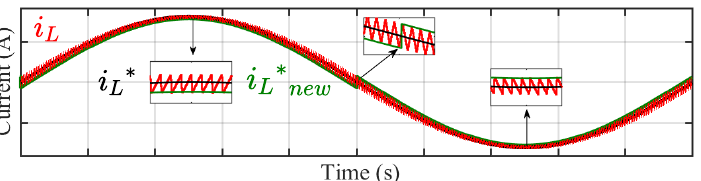
Figure 12. Sketch of Inductor current obtained with the variable offset corrected reference.